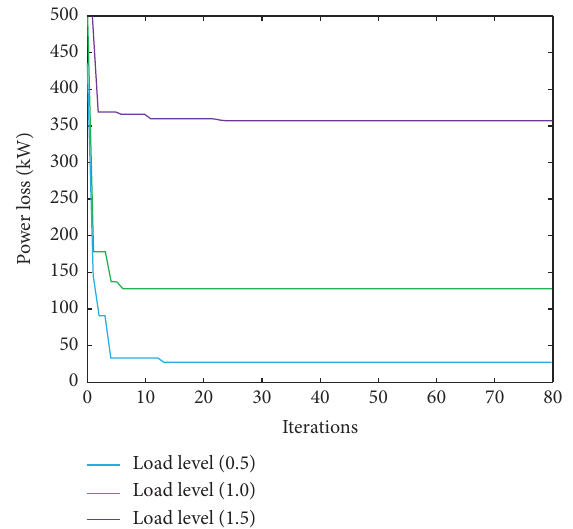
Figure 13: Convergence characteristics of power loss using HBO.